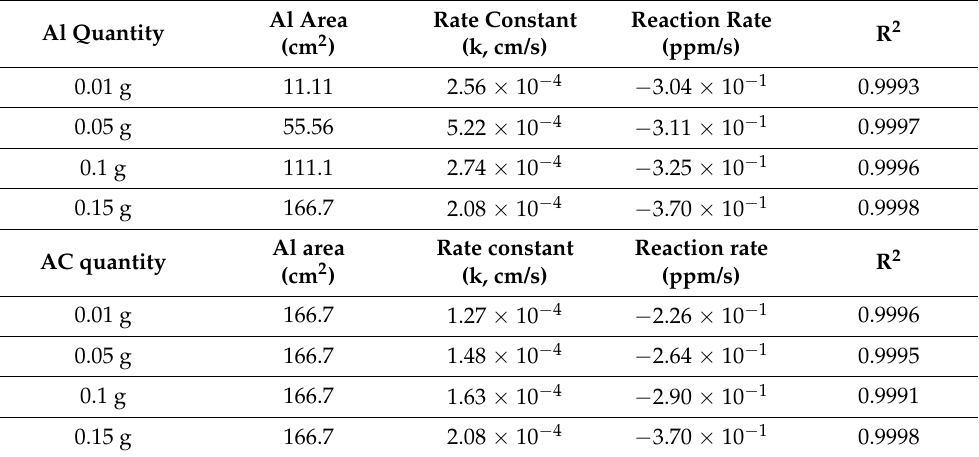
and AC quantity (base conditions: 10 mL solution containing 1 M of Na 2 S 2 O 3 , 0.5 M of NH 3 , 0.25 M of (NH 4 ) 2 SO 4 and 10 mM of CuSO 4 , and 0.3 g mixture (Al and AC) at 25 ◦ C).